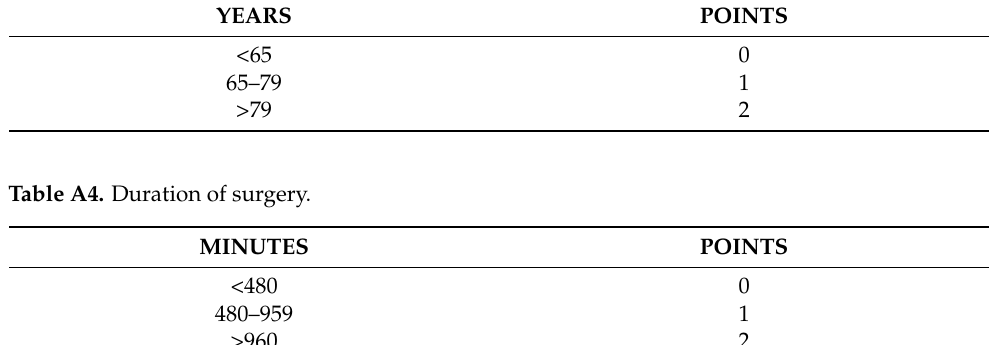
Table A6. Preoperative hemoglobin — Blood loss ratio — Sex.